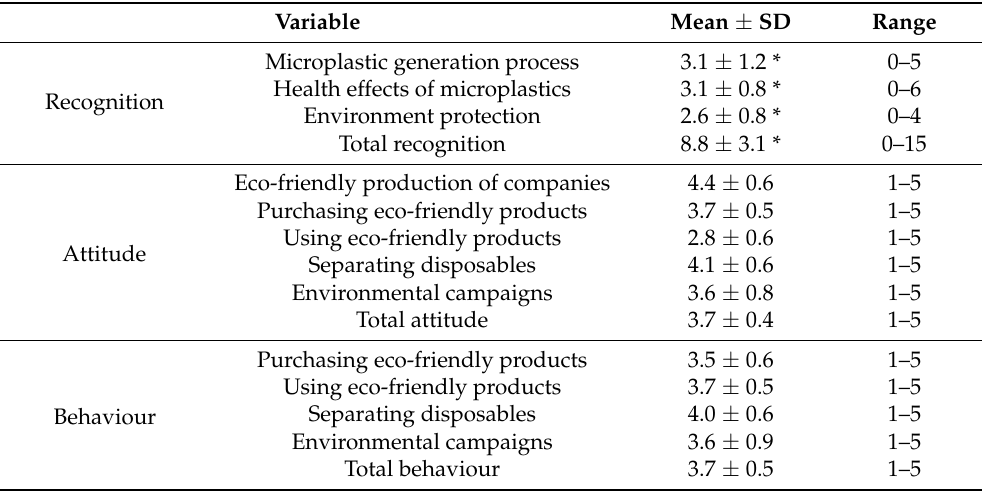
Table 2. Zero-waste recognition, attitude, and behaviour (n =